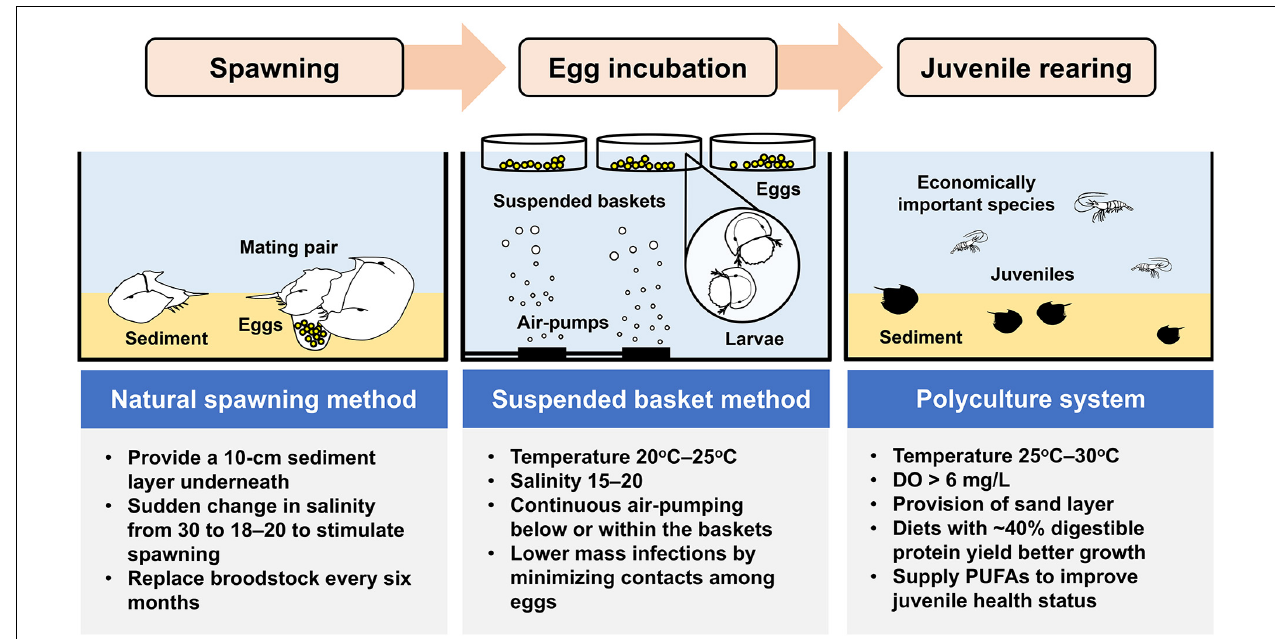
FIGURE 2 | Important techniques and operating procedures on artificial breeding as well as larval and juvenile culture for T. tridentatus